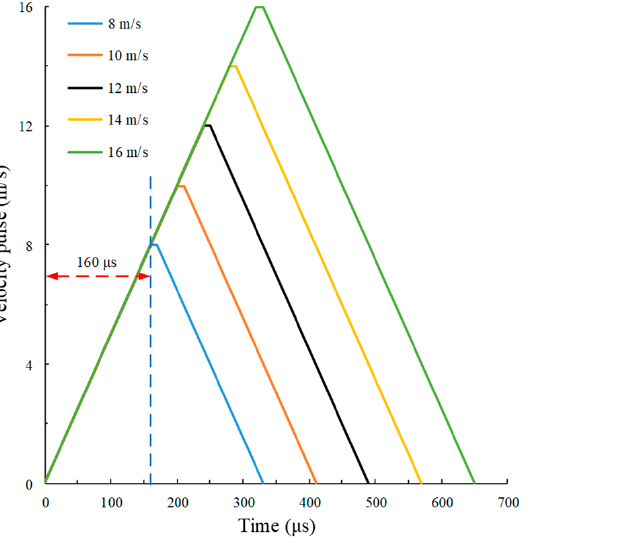
Figure 5. Velocity pulse waveform. ( a ) Different amplitude; ( b ) different rise time.